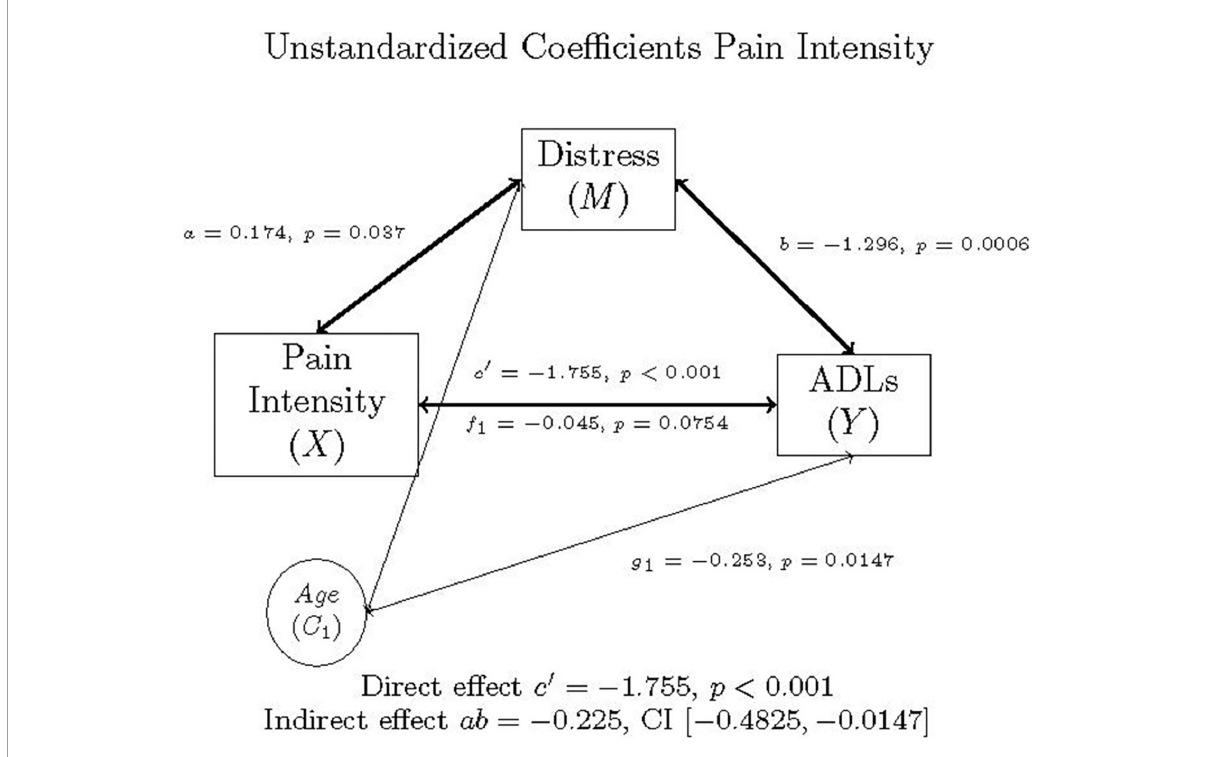
FIGURE1 Mediation model of pain intensity, distress, ADLs, and age in individuals with FM, as well as the direct effect, indirect effect, and confidence interval using unstandardized (b) coefficients.